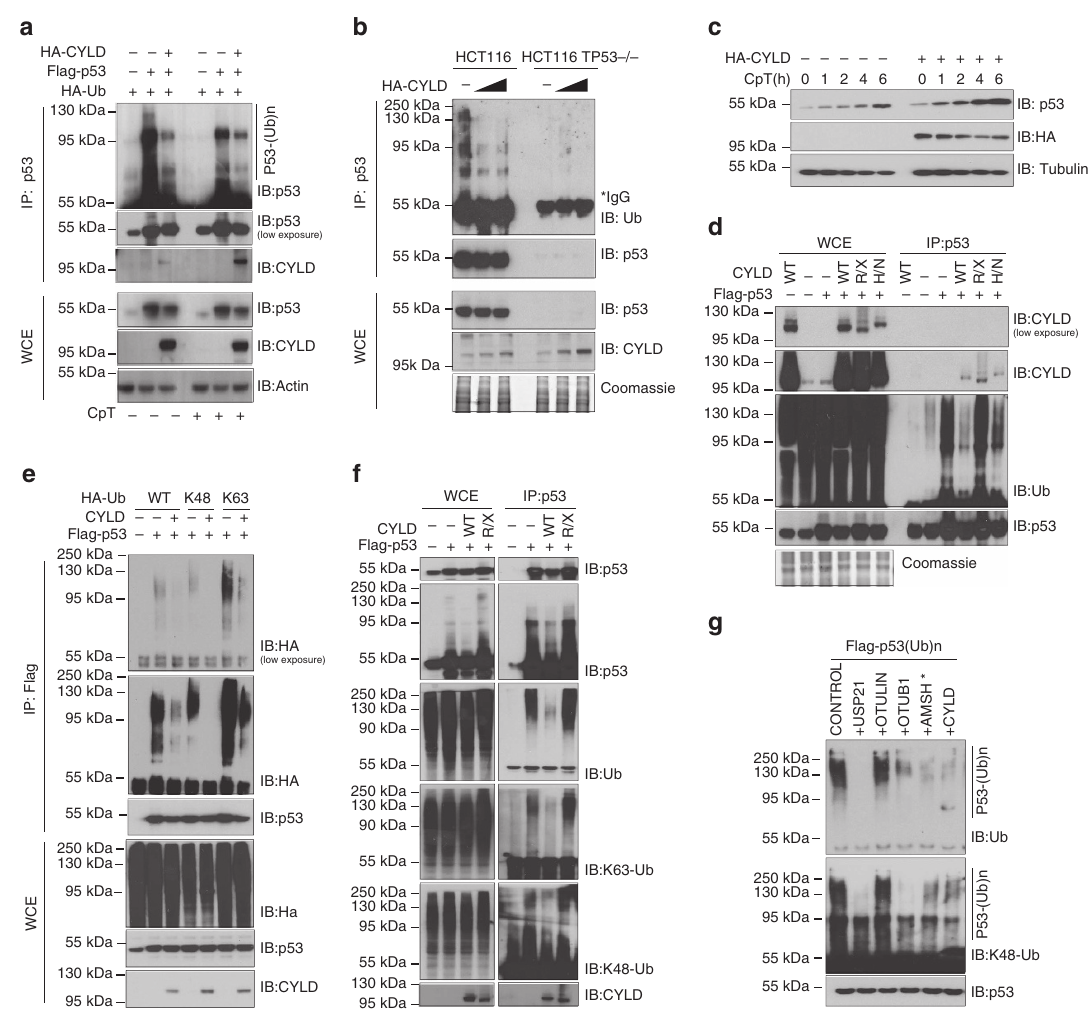
Figure 7 | CYLD deubiquitinates p53 and induces its stabilization. HEK-293T ( a , d ) and HCT116 ( b ) cells were transfected with the indicated plasmids and were subsequently treated with MG-132/CpT. p53 was immunoprecipitated followed by immunoblot with anti-p53(DO-1), anti-ubiquitin and anti- CYLD antibodies as indicated. Expression levels of p53 and CYLD proteins are shown in immunoprecipitates and WCE. ( c ) HCT116 were transfected with HA-CYLD or an empty vector and treated with CpT for the indicated time points followed by immunoblot with anti-p53, HA and tubulin antibodies. ( e , f ) HEK-293Tcells were transfected with the indicated constructs and treated with MG-132/CpT. p53 was immunoprecipitated and its levels and type of ubiquitination were analysed by immunoblot using the indicated antibodies. ( g ) Ubiquitinated Flag-p53 (Flag-p53(Ub)n) was immunoprecipitated from MG-132/CpT-treated HEK-293Tcells and subjected to an in vitro deubiquitination assay using the indicated DUBs. Total and K48-linked ubiquitin chains on p53 are shown by immunoblot using specific